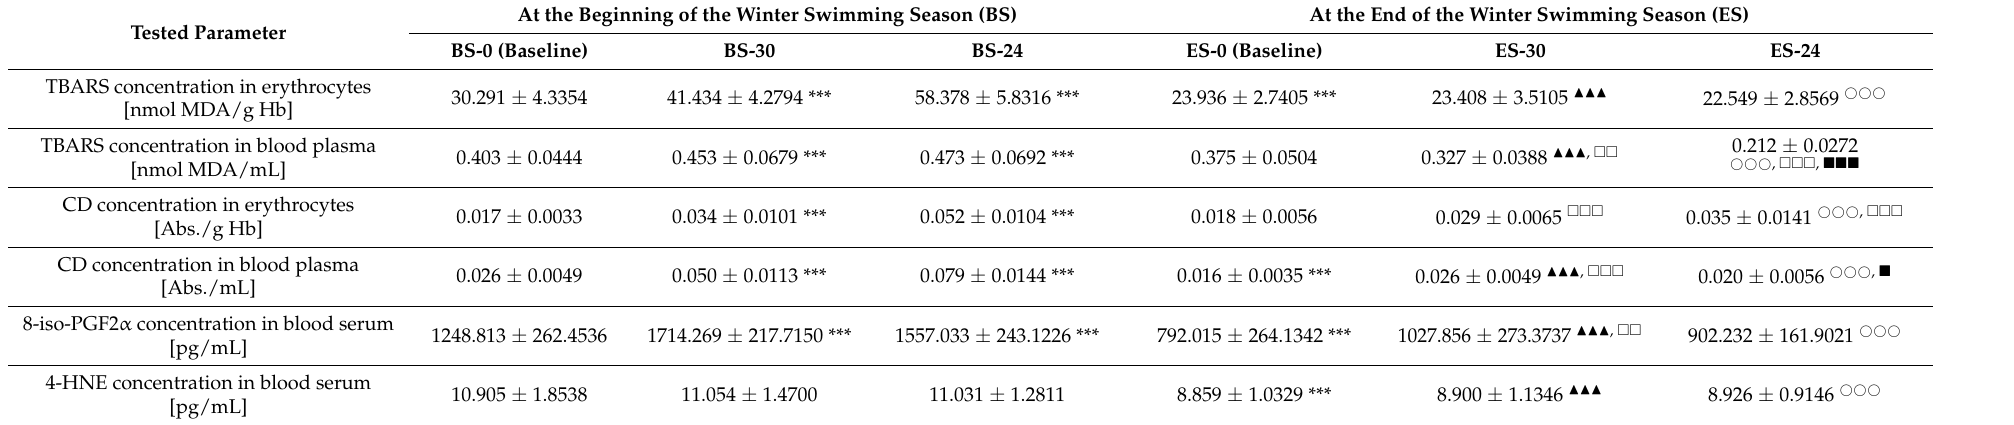
Table 3. The concentration of lipid peroxidation products in the blood of winter